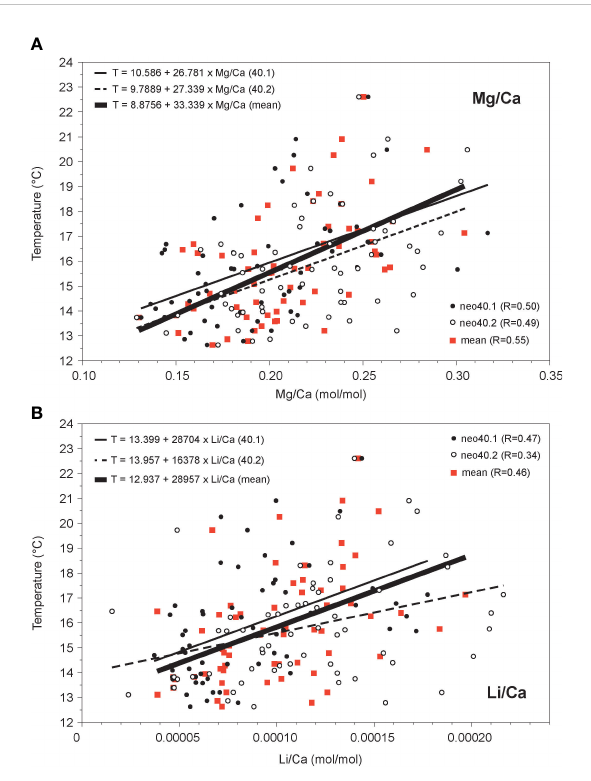
FIGURE 7 Comparison of (A) Mg/Ca and (B) Li/Ca ratios to in situ temperature (2012-17) for sample neo40. Linear regressions for monthly data are signi fi cant (p<0.01), with regression line shown in bold (sample mean), solid (transect neo40.1), and stippled (transect neo40.2). Equations and correlation coef fi cients (R) are shown for each regression. Both ratios are positively correlated to temperature.